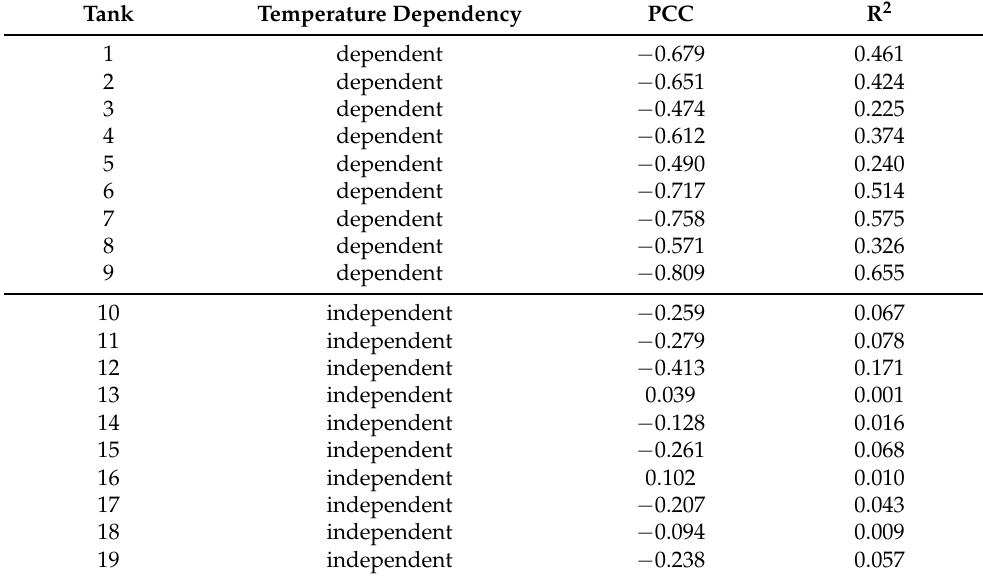
Table 2. The dependence of LPG consumption on outside temperature values expressed by means of the Pearson correlation coefficient (PCC) and the determination coefficient (R 2